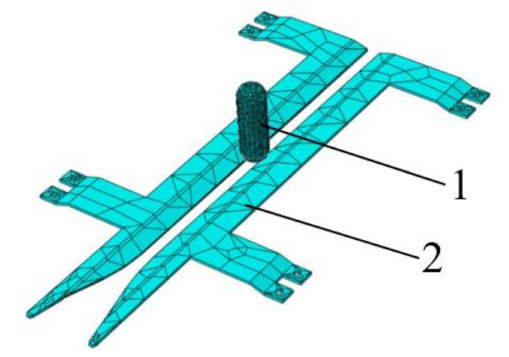
Figure 7. Contact model between ear and snapping plate. (1) Ear; (2) snapping